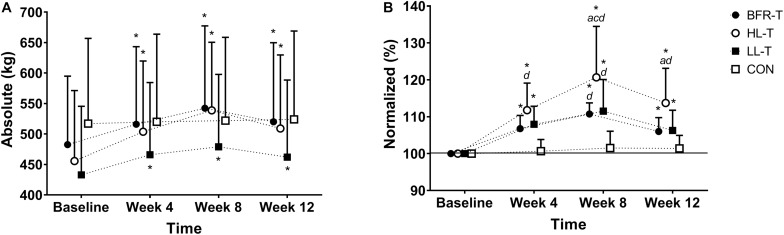
Absolute (A) and Normalized (B) change in Total Tonnage. ∗ indicates significant Group x Time interaction (P ≤ 0.0001); a significantly different to BFR-T; b significant different to HL-T; c significantly different to LL-T; d significantly different to CON.